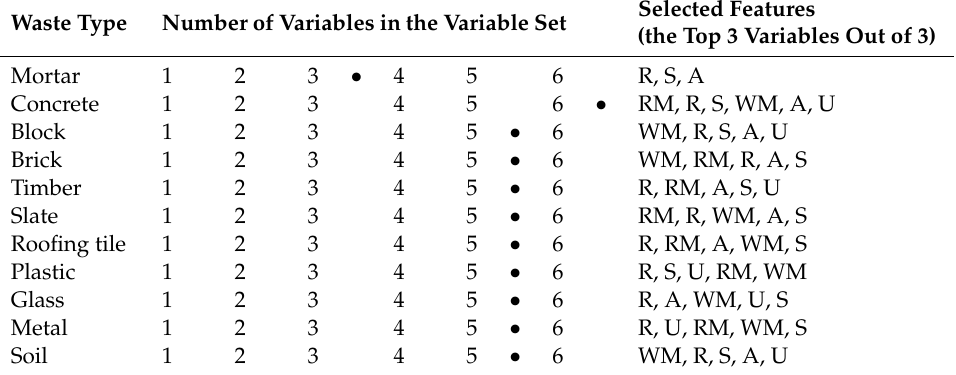
Table 2. Results of feature selection produced by RF-recursive feature elimination (RFE). • Selected Variable